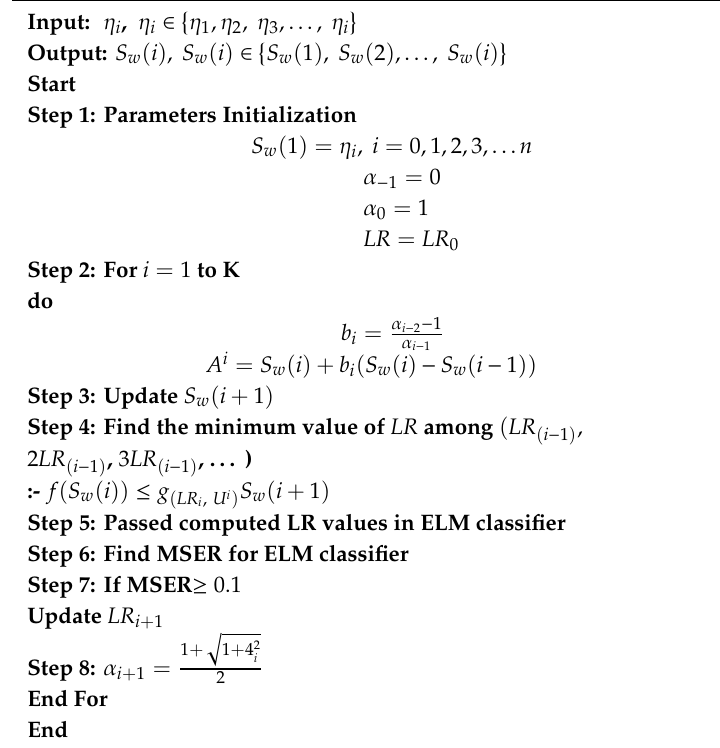
Algorithm 1 Proposed feature selection method using